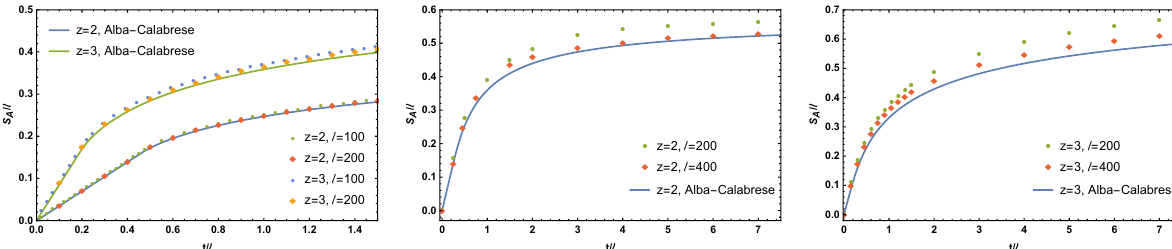
Figure 6 . Analytic versus numerical results for the evolution of EE in Lifshitz harmonic lattice. In the left panel we have set m 0 = 1 and m = 2 and in the middle ( z = 2) and right ( z = 3) panels we have set m 0 = 1 and m = 0. In the left panel there is perfect agreement between Alba-Calabrese quasi-particle picture and numerics. In the middle panel one can see that due to the zero mode e(cid:11)ect even for ‘ = 400 numerics deviate from Alba-Calabrese picture around the o(cid:11)set of tortoise saturation regime. The same is correct for higher values of z although one must wait much longer to see